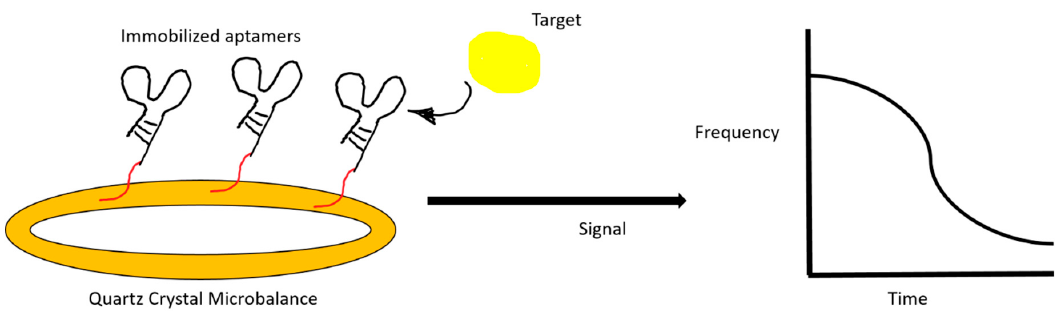
Figure 5. An illustration of a quartz crystal microbalance aptasensor. The change in resonance frequency after target binding is registered on a monitor. Table 2. Summary table of new ssDNA aptamers selected against bacteria and bacterial related targets and their diagnostic and biosensing